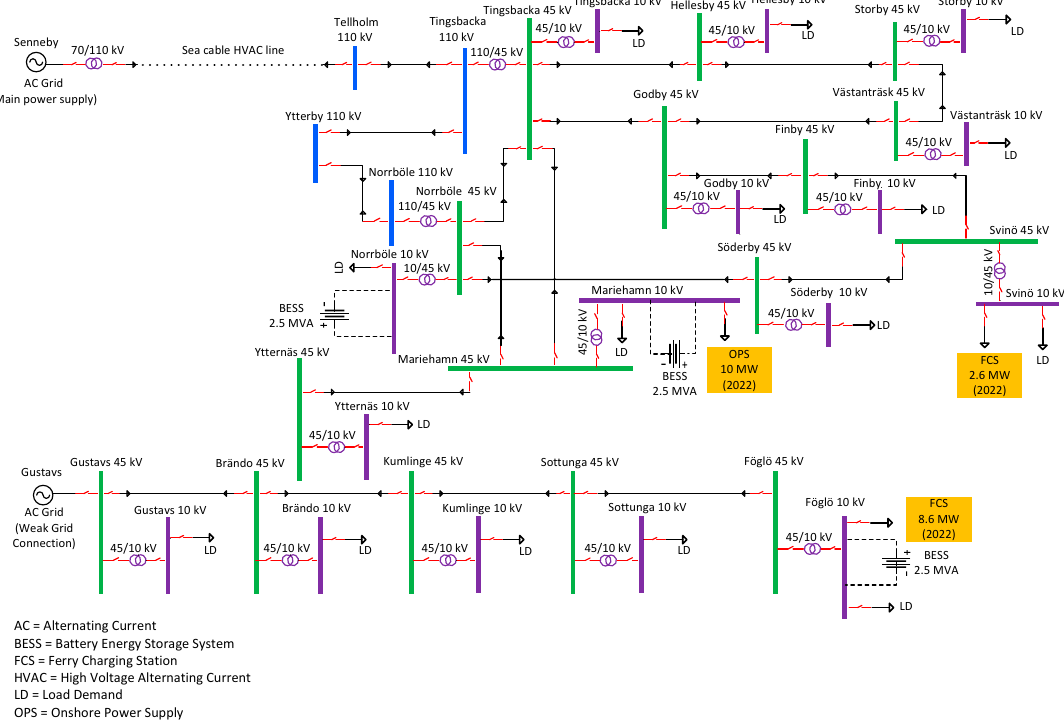
Figure 12. Meshed mode operation of the Åland Islands’ power system for the year 2022 with BESSs.